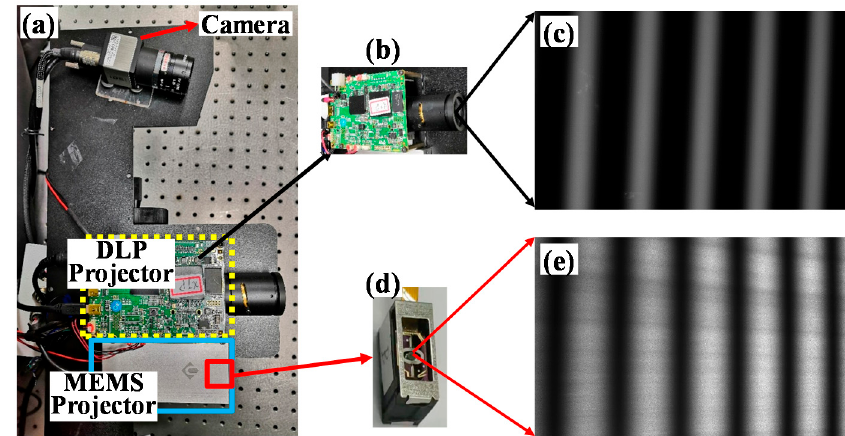
Figure 4. The experimental setup for this FPP measurement system, the projector of galvanometer scanner (MEMS) and digital light projector (DLP) are used to project fringe patterns, respectively. The experimental system uses one projector and one camera. ( a ) Experimental setup; ( b ) DLP projector; ( c ) Projected fringe by DLP; ( d ) MEMS projector; ( e ) Projected fringe by MEMS.